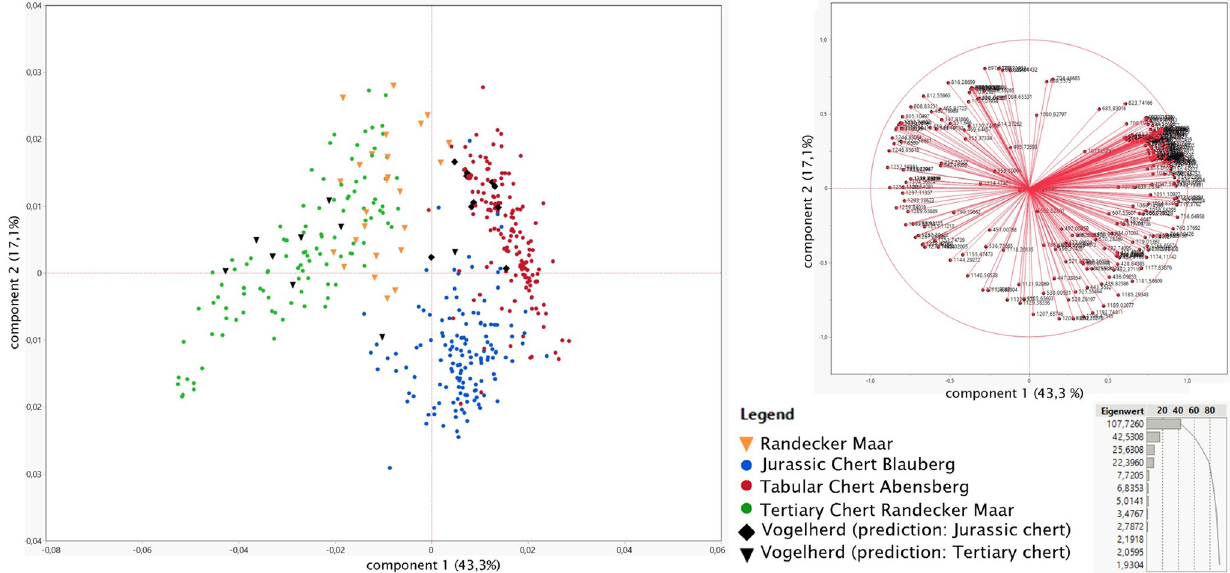
Fig 5. PCA scatter plot (covariance matrix) resulting from the first derivative data of these spectra (left) and the loading plot showing the direction different variables (in our case different wave numbers) plot in the PCA biplot and first two principal components (top right); and the eigenvalue (right bottom). All archaeological samples from the Randecker Maar were macroscopically predicted to be Tertiary chert, these are shown as orange triangles. The samples from Vogelherd predicted to be Tertiary chert by macroscopical analysis are shown as black triangles. The samples predicted to be Jurassic chert from Vogelherd are shown as black